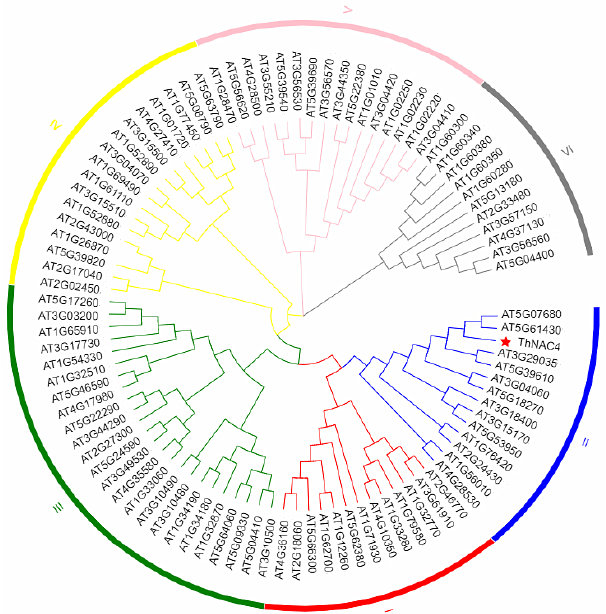
Figure 1. Phylogenetic analysis of ThNAC4 and NAC proteins from Arabidopsis . The phylogenetic relationship of ThNAC4 and NAC proteins from Arabidopsis . ThNAC4 and the Arabidopsis NACs were aligned; the unrooted NJ tree was constructed using MEGA 7 .